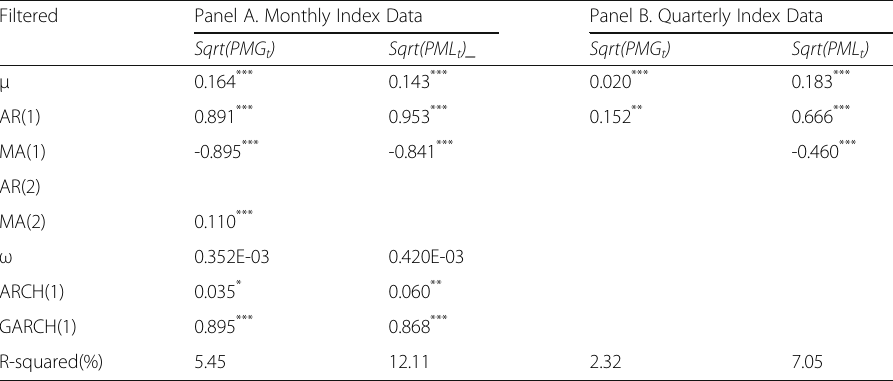
Filtered Panel A. Monthly Index Data Panel B. Quarterly Index